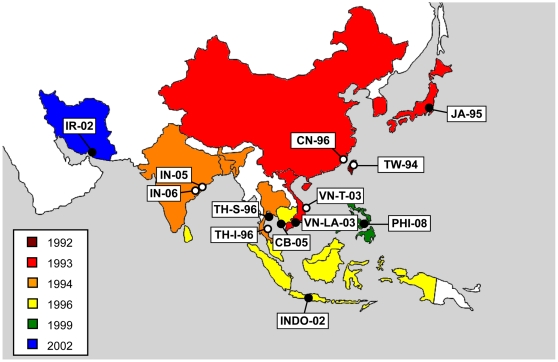
Map of Asia, showing the geographical origins of WSSV isolates used for this study.New isolates characterized in this study are marked with black circles, whereas isolates previously reported in the literature are marked with white circles. Further information on the isolates is given in Table 1. Colors denote the year of first outbreak for Asian countries for which this information is known (see Materials and Methods).